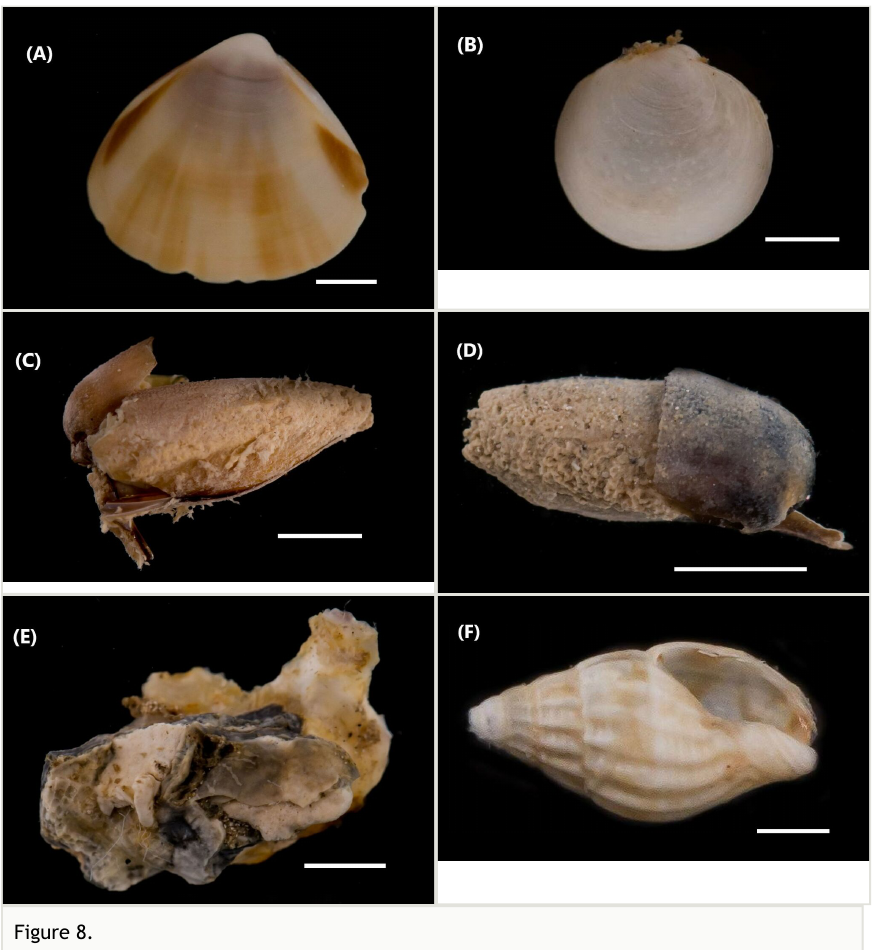
Figure 8. Molluscs identified on the beaches from Paraíba coast. Scale bars = 500 µm (A and C-F), 250 µm (B). Photos: (A-F) by Freitas,